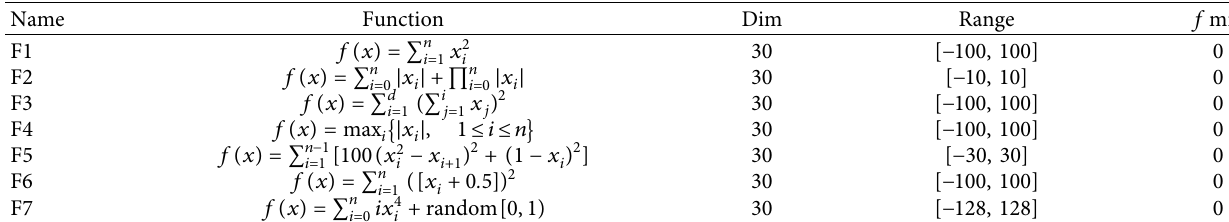
Table 1: Unimodal test